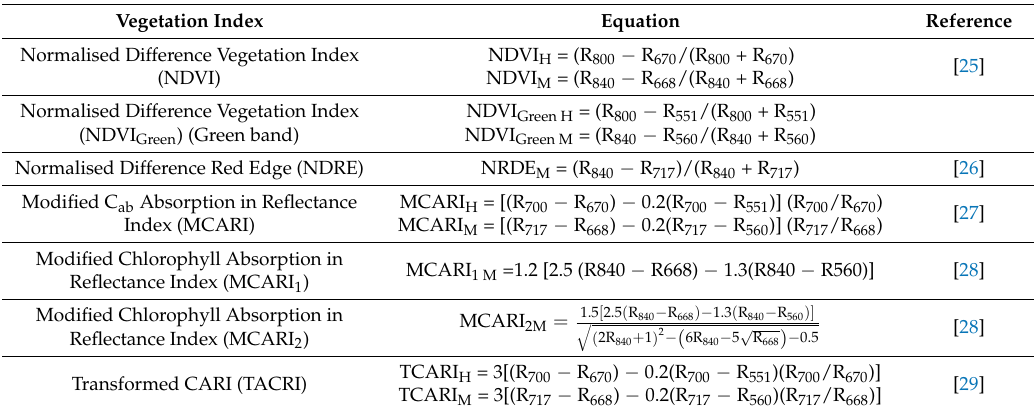
Table 1. Vegetation indices used in the analysis of the phylloxera infestation in vineyards. Vegetation Index